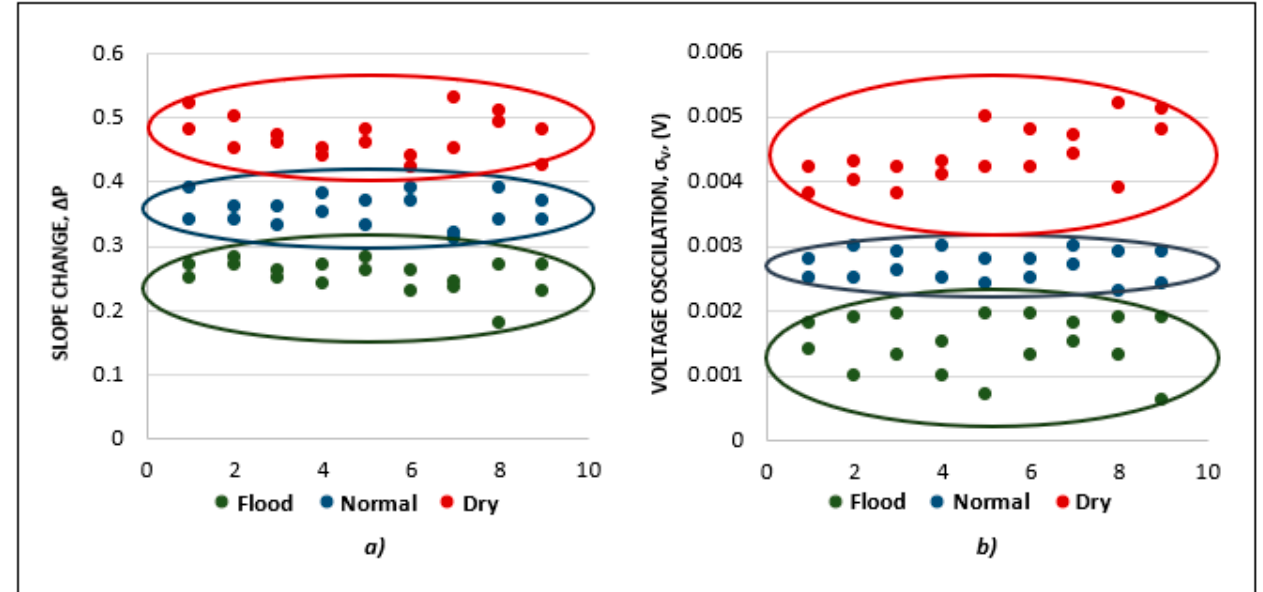
Figure 5. Model to estimate water in the PEMFC. ( a ) SLOPE CHANGE. ( b ) VOLTAGE OSCILLATION.